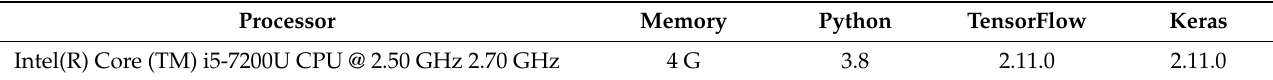
Table 5. Experimental environment